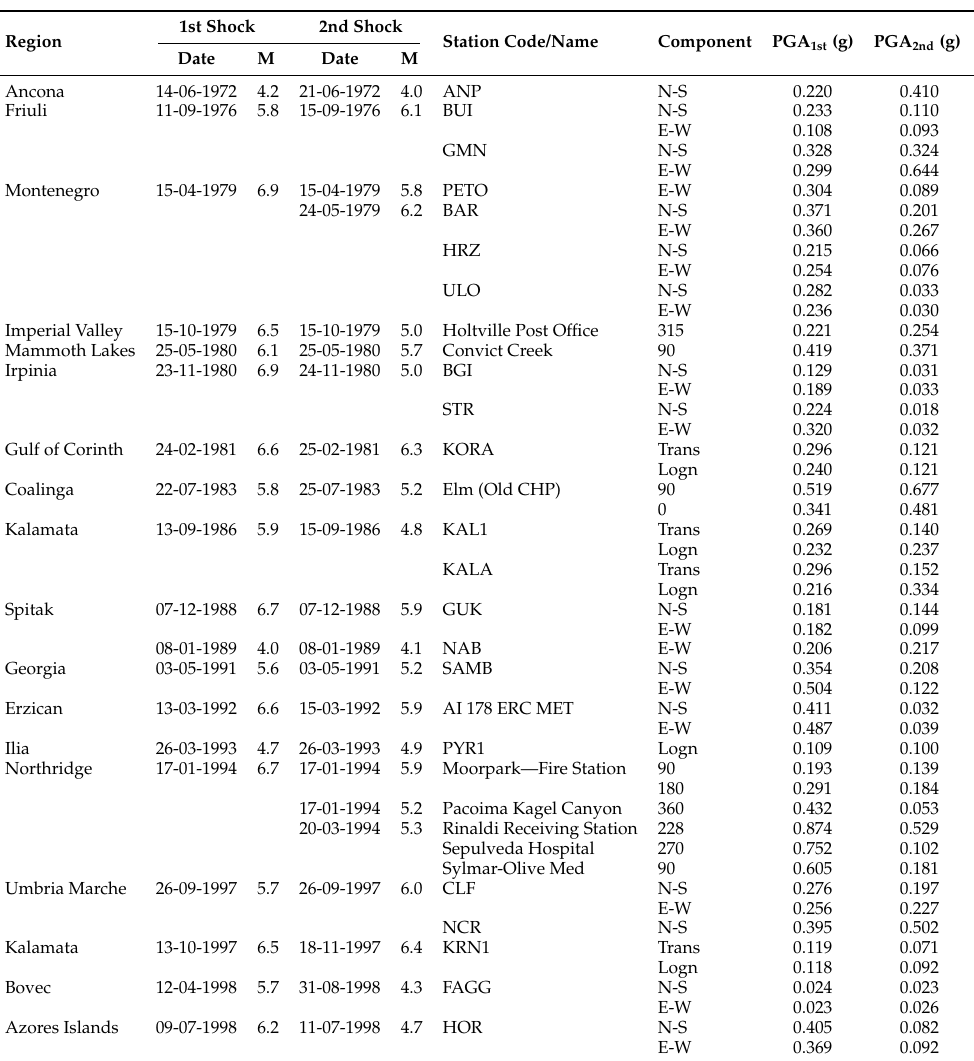
Table A2. Seismic metadata for natural